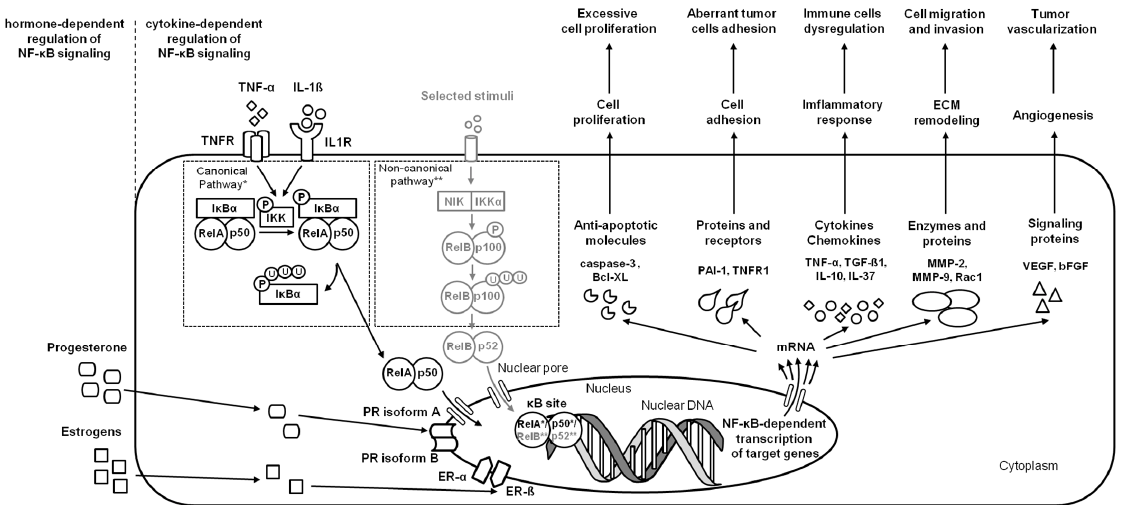
Figure 4. A simplified schema of the NF- κ B signaling pathway in the endometrium in the case of endometrial carcinoma. Studied pathways are marked in black. Pathways requiring further research are marked in grey. Both canonical pathway * and noncanonical pathway ** are considered.